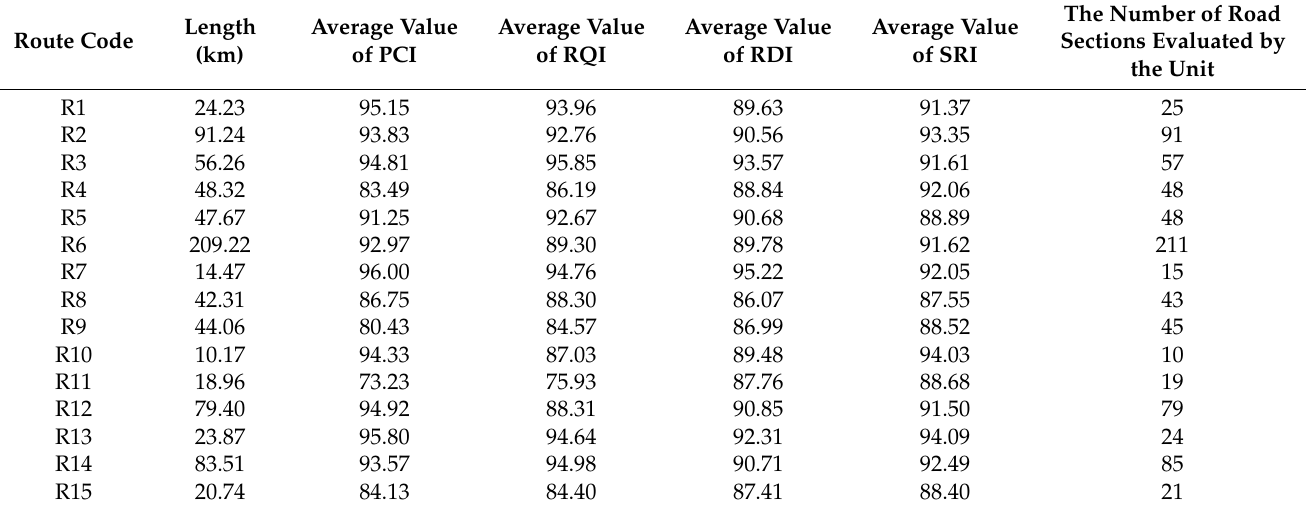
Table 1. Observed pavement condition data of a highway network in